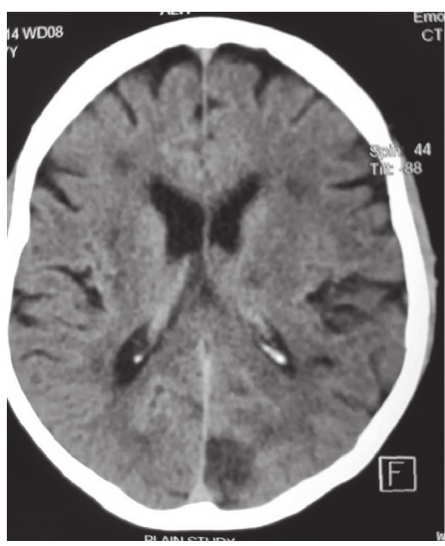
Figure 1: Noncontrast CT scan of the brain showing bilateral watershed infarctions in the fronto-parietal regions and a right- sided occipital infarction.